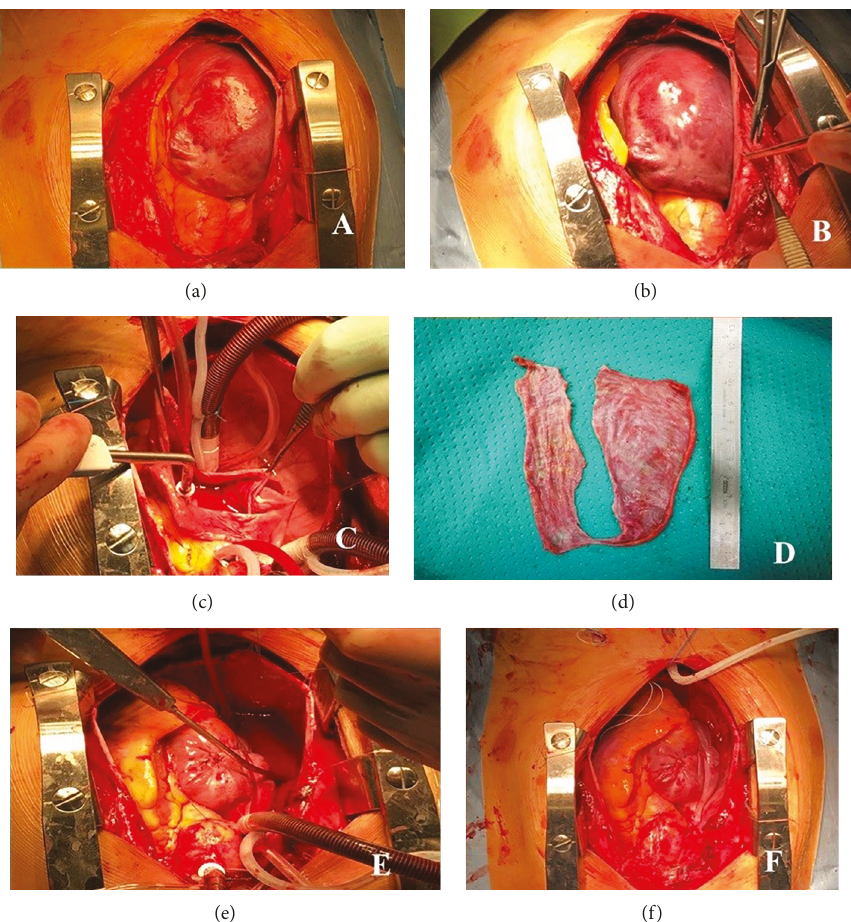
Figure 4: (a, b) Intraoperative view showing the large dilation of the right atrium. (c) The right atrium was fully opened and resected. (d) The resected portion of the right atrium. (e, f) Atrial incision was closed as shown, reconstituting an atrial chamber of approximately normal size and con fi